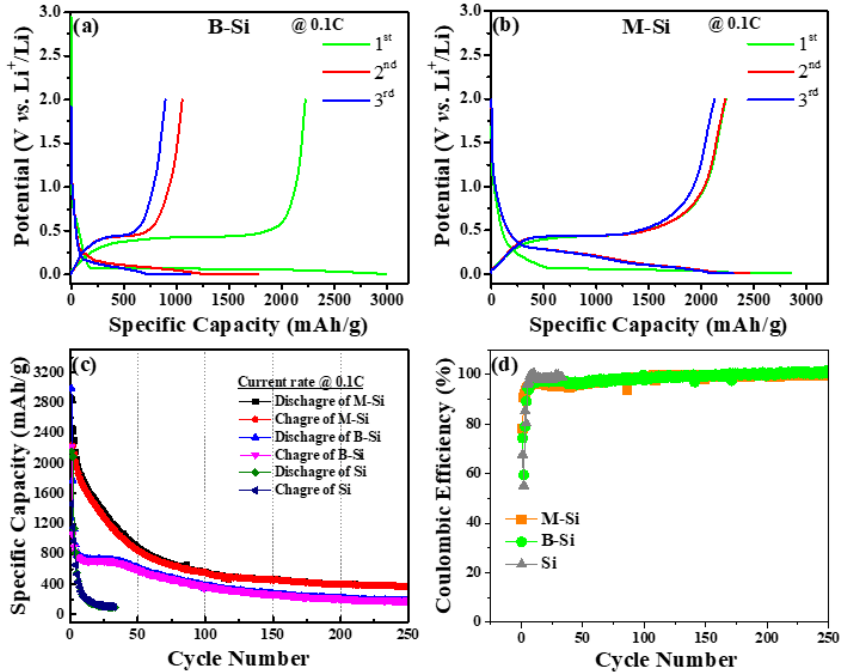
Figure 8. Charge/discharge curves of ( a ) B-Si and ( b ) M-Si at the first three cycle at 0.1C. ( c ) Cycle life tests of pure Si, B-Si, and M-Si at 0.1C. ( d ) Corresponding coulombic efficiency of pure Si, B-Si and M-Si, respectively.